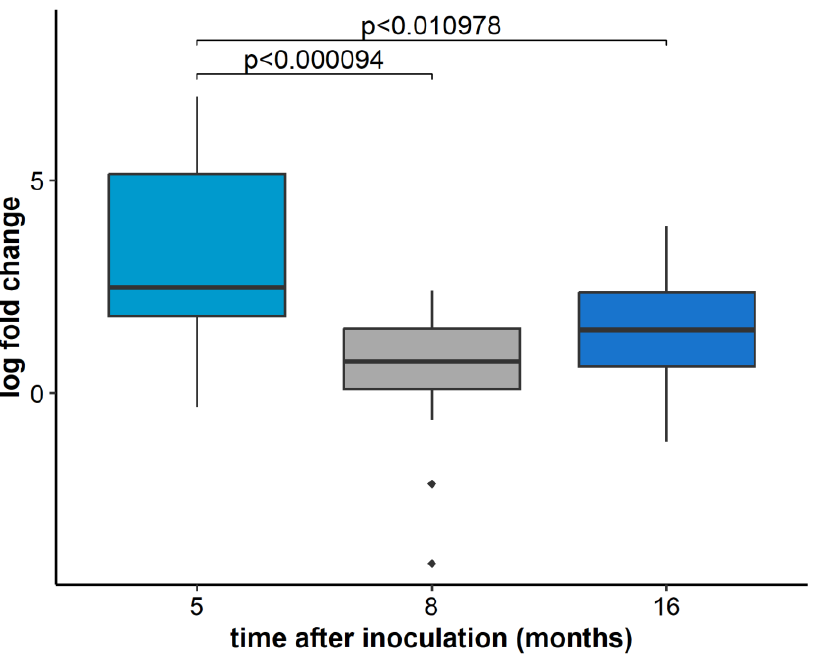
Figure 1. The relative concentration of GLRaV-3 based on ORF1a analysis in five, eight, and 16 months after inoculation, calculated as an average value for all inoculated plants of all varieties. Results are displayed as logarithmic ratios of relative concentration. ANOVA test was performed along with the Bonferroni post hoc test and significantly different values ( p < 0.05) are marked above individual box plots. Outlier measurements that are 1.5 times over the upper/lower quartile of the dataset of an individual boxplot are marked with ◆ .